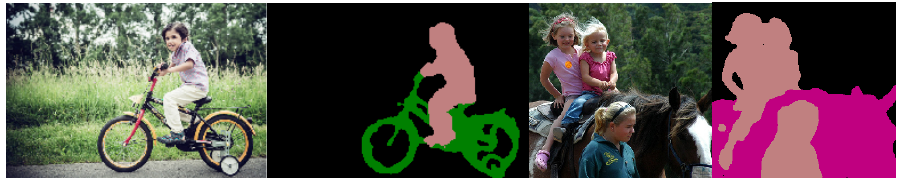
Figure 4. Examples of the image masks from DeepLabv3+. These images come from the Pascal Visual Objects Category dataset. Each color denotes a different class label, with black being